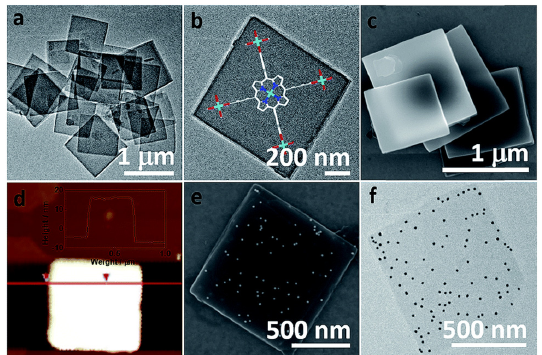
Figure 4. ( a , b ) TEM images with different magnifications and ( c ) SEM and ( d ) AFM images of PPF-3_1. ( e ) SEM and ( f ) TEM images of Au–PPF-3_1A. Inset is the profile of a PPF-3_1 nanosheet in the AFM image. Reproduced with permission from [99]. Copyright 2019, the Royal Society of